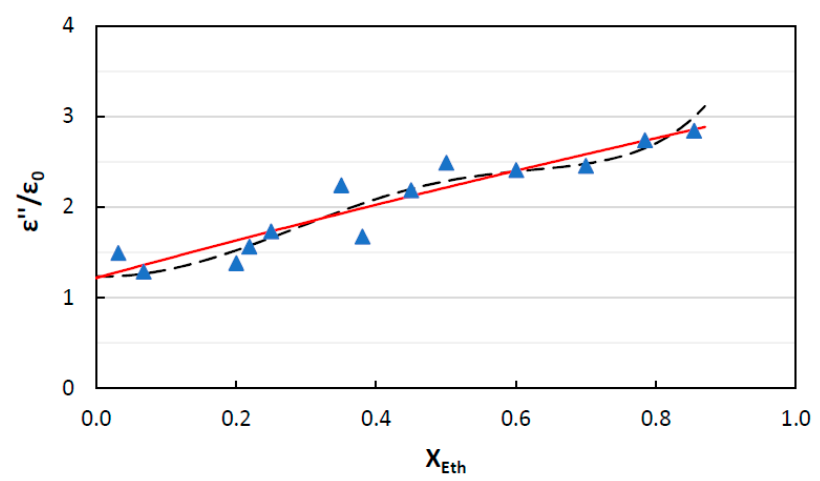
Figure 7. Measured values ( ▲ ), Acree model curve (---), and King and Queen model curve ( − ) of 𝜀 (cid:4593)(cid:4593) /𝜀 (cid:2868)